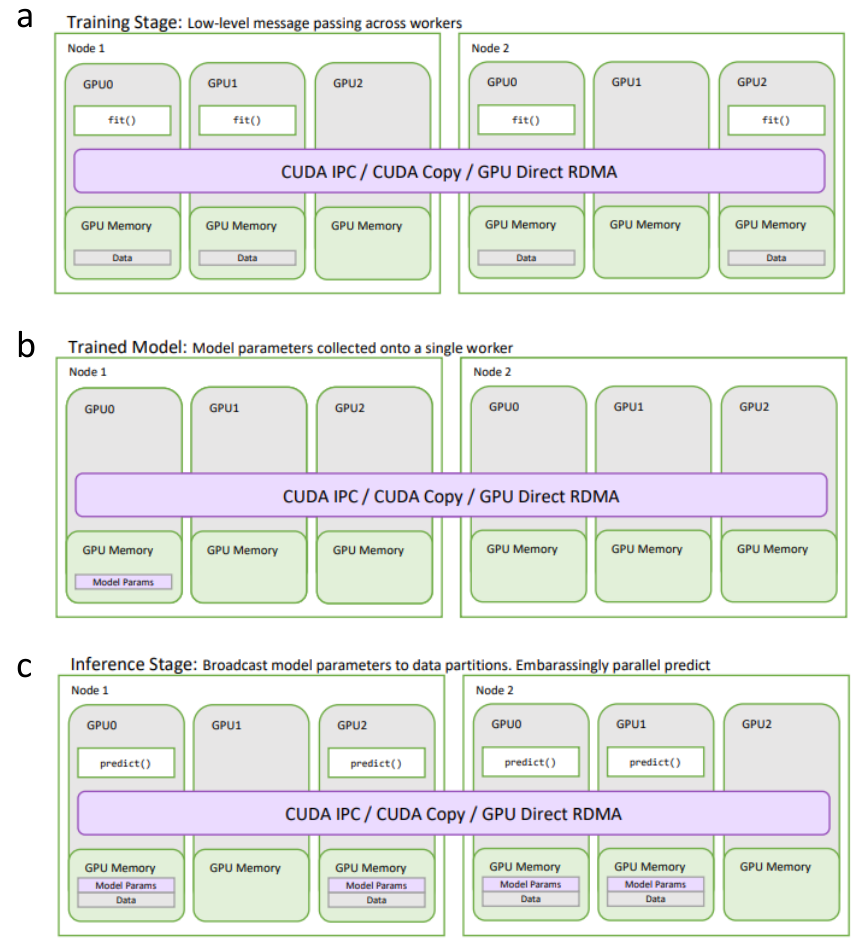
Figure 6. General-purpose distributed GPU computing with Dask. ( a ) distributed cuML training. The fit() function is executed on all workers containing data in the training dataset; ( b ) distributed cuML model parameters after training. The trained parameters are brought to a single worker; ( c ) distributed cuML model for prediction. The trained parameters are broadcasted to all workers containing partitions in the prediction dataset. Predictions are done in an embarrassingly parallel